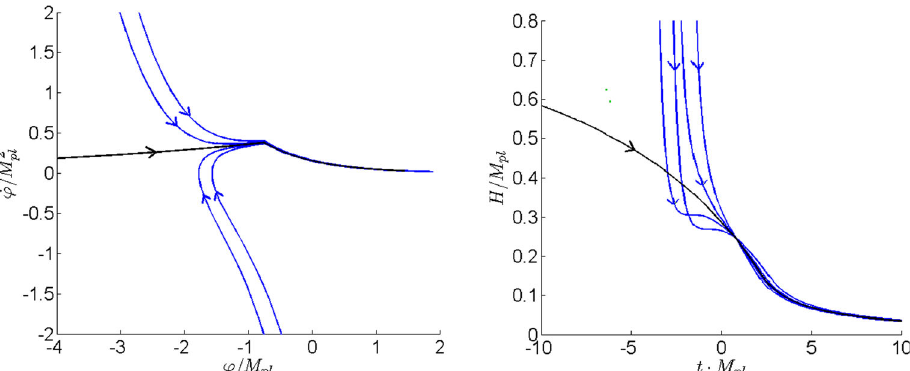
) (left) for some orbits, with the analytical one represented in black. Evolution of H / M pl